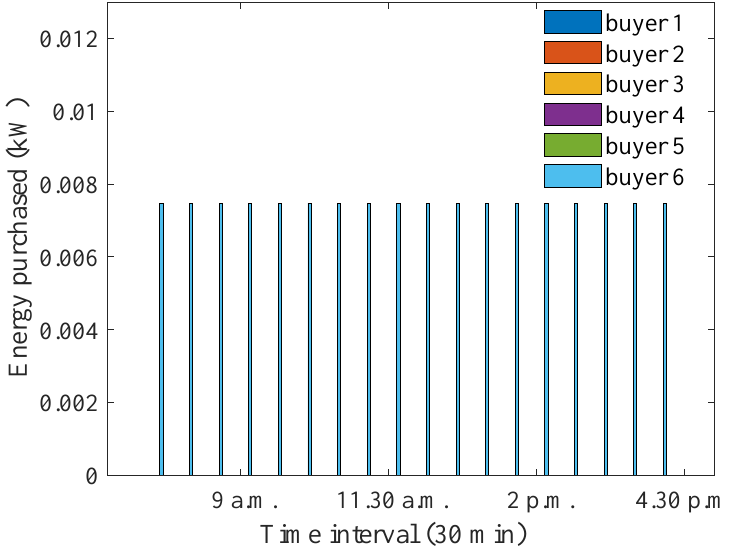
Figure 24. Optimum energy purchased for equally preferred sellers and buyers when distance between house 1 and the aggregator is